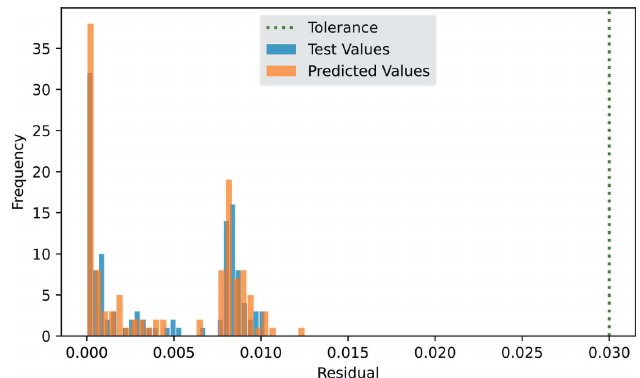
Figure 9 Histogram comparing the residuals for predictions on | S 3| = 1 cases by the NN4 model with the residuals from the test data set. These cases correspond to cases where the test value of | S 3| = 1 within a tolerance of (cid:5) 0.01.